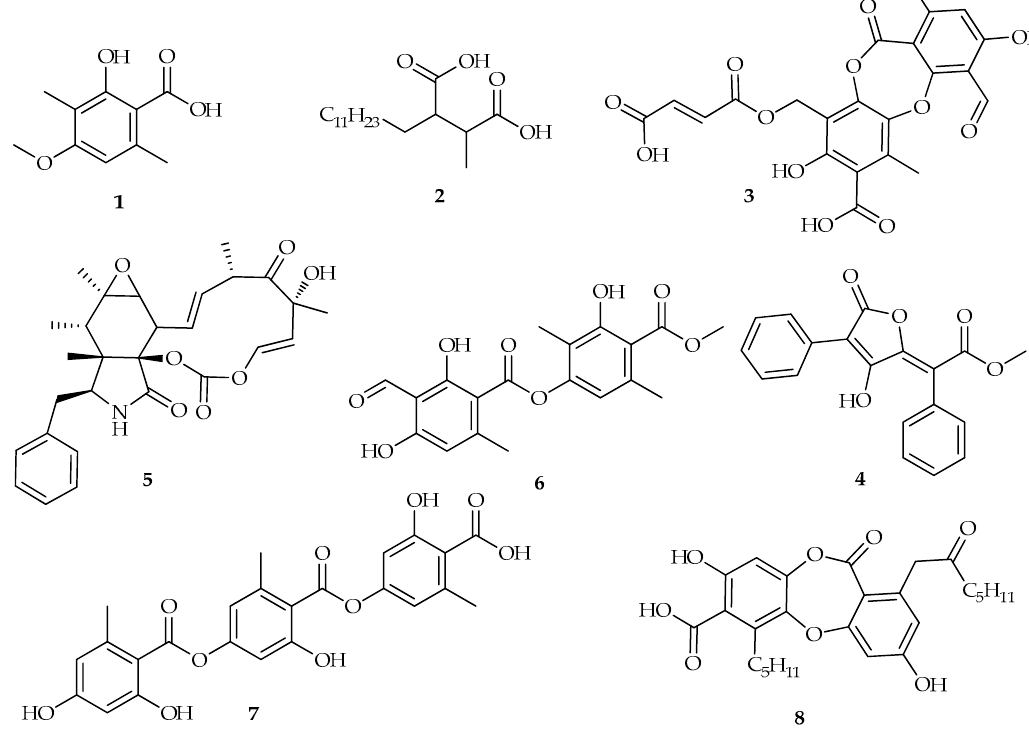
Figure 1. Notable anticancer active lichen secondary metabolites with succinic, lactam, depside, didepside, tridepside and a depsidone molecular backbone.